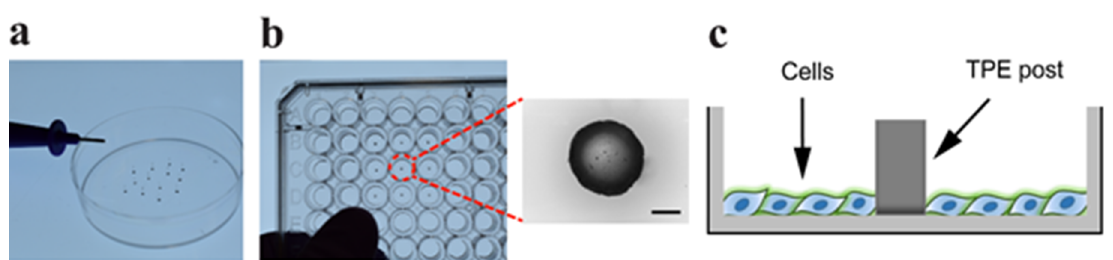
Figure 1. Thermoplastic elastomer (TPE) post preparation: ( a ) TPE posts were made using a 1 mm diameter biopsy punch ( b ) and attached in center of individual wells of a 96-well cell culture plate. The image inset shows the rounded shape of the TPE post. The scale bar represents 200 µm. ( c ) Schematic drawing of the TPE-assisted cell patterning platform.